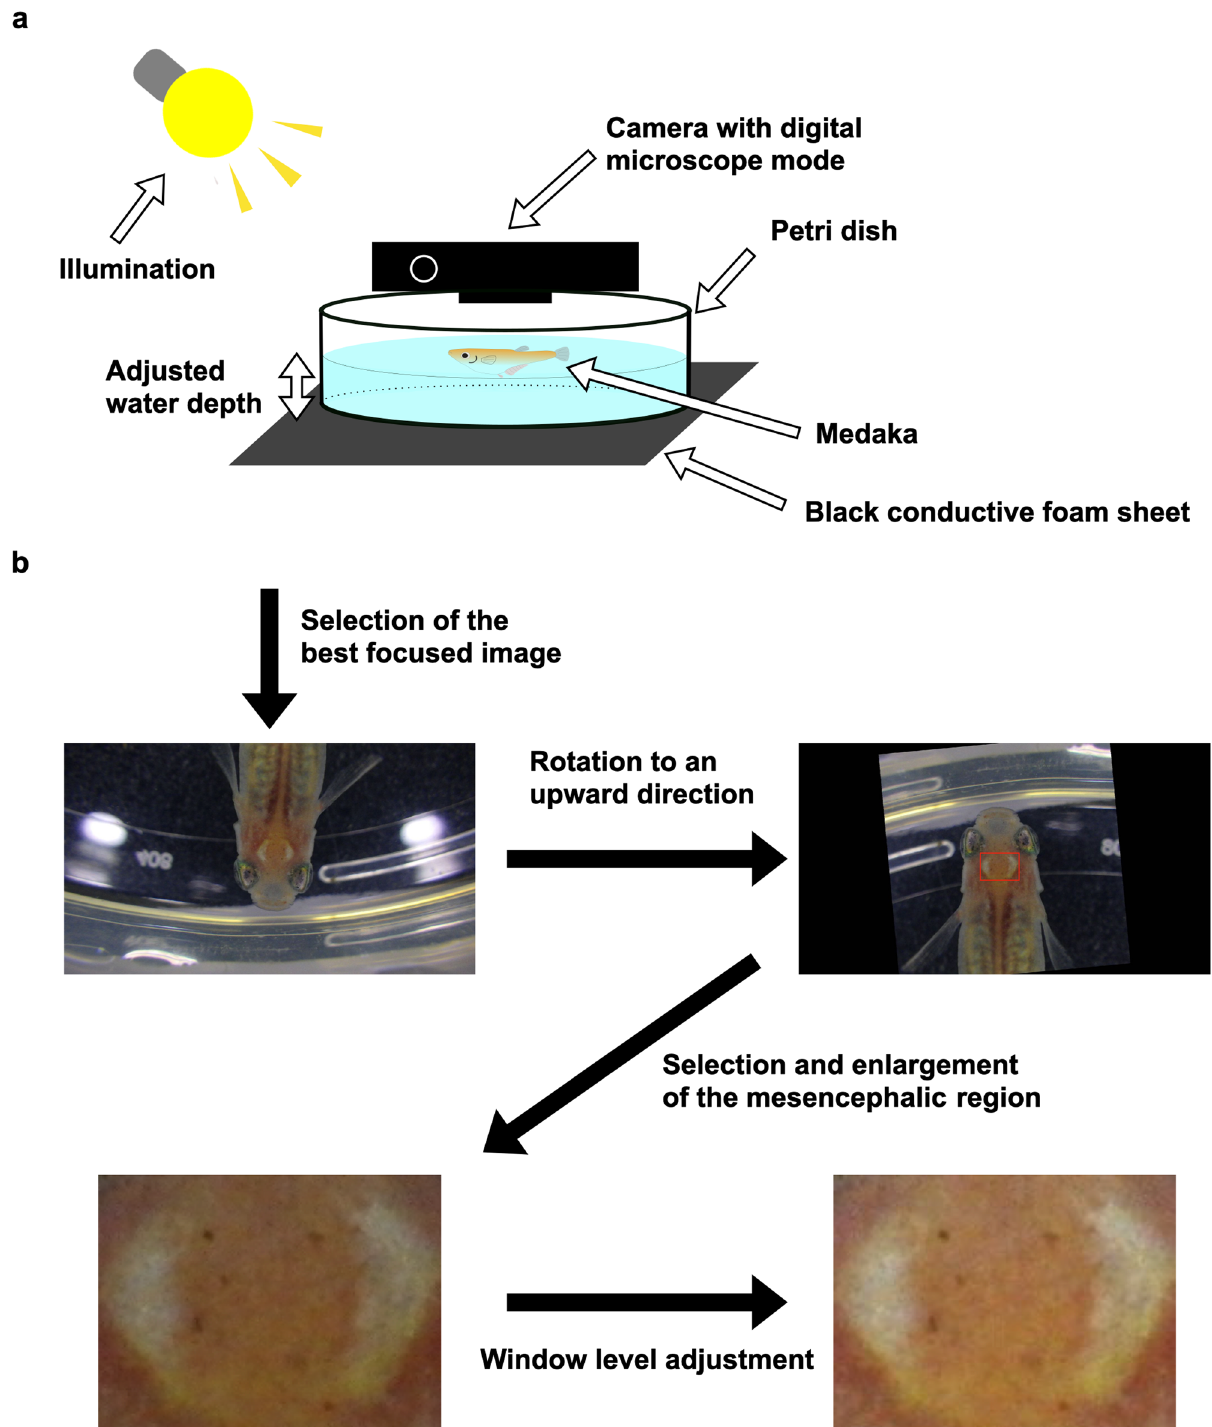
Figure 6. Flowchart for obtaining an individual distribution pattern of melanophore spots. ( a ) Setup for the acquisition of head images of individual medaka. A medaka was placed in a Petri dish at an adjusted water depth on a black conductive foam sheet (Supplementary Fig. 1). The illumination was provided by a ceiling and desk lights (Supplementary Fig. 2). The medaka head region was photographed from above using a camera with digital microscopic mode. ( b ) Image processing flow. The best focused image was chosen for further processing. The image was rotated to an upward position (ImageJ 1.53a) and the mesencephalic region was selected in the red rectangle (ImageJ 1.53a) and enlarged (Keynote 11.2). Finally, the window level was adjusted to facilitate melanophore spot detection (Keynote